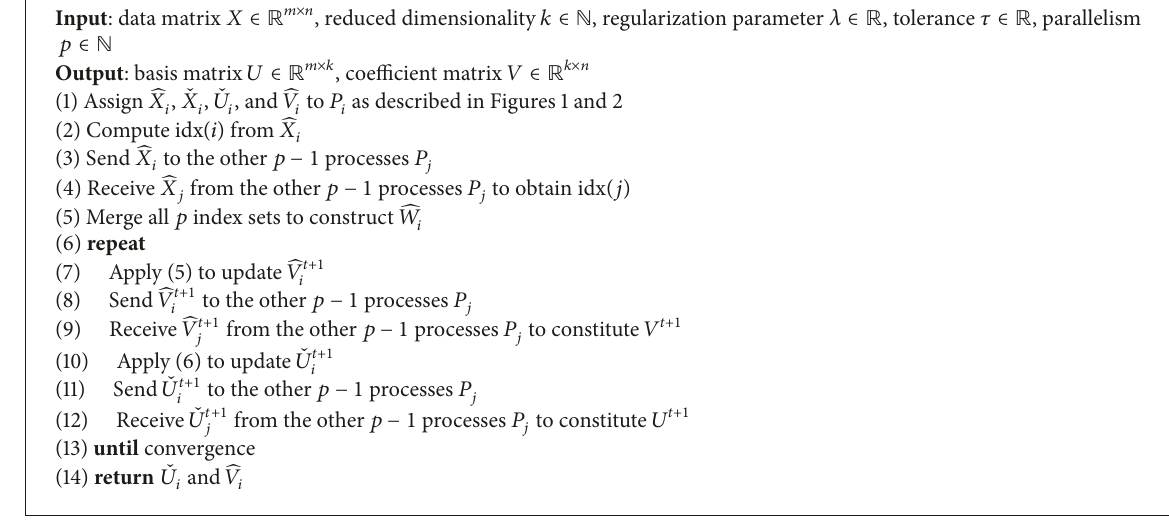
Algorithm 1: PNMF-M procedure.